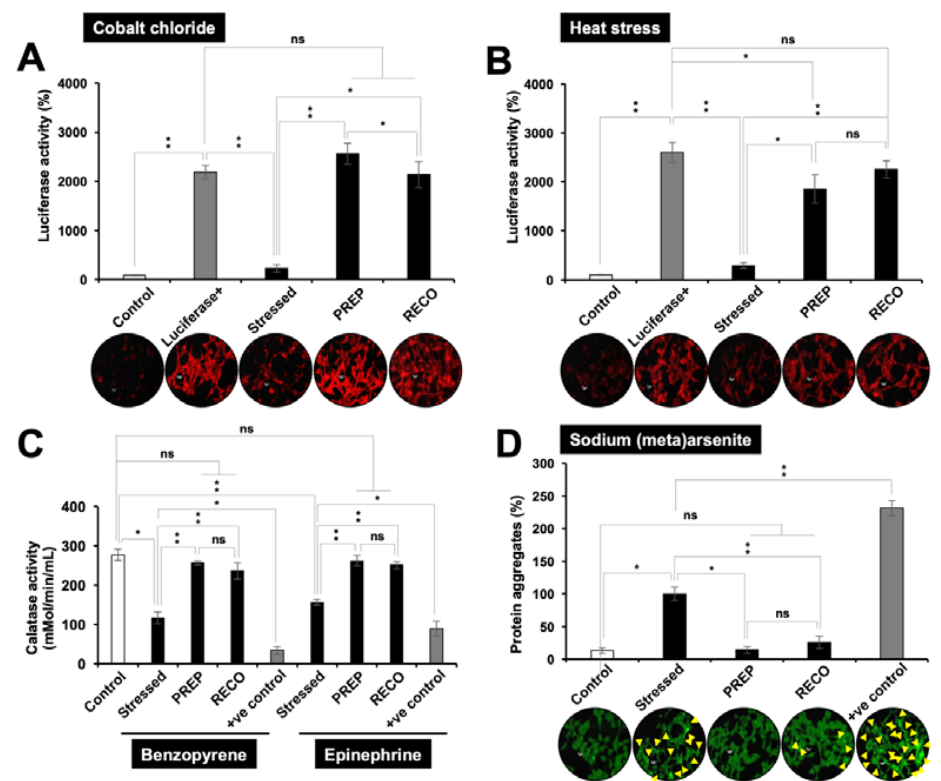
Figure 3. Luciferase reporter assay on control, cobalt chloride ( A ) and heat-stressed ( B ) treated cells in PREP and RECO modes. Relative units of luminescence (luciferase activity (%)) from three independent experiments were plotted. Cells exposed to metal (200 µ M cobalt chloride) and heat (42 ◦ C) stress showed inactivation of luciferase activity that was revived in resveratrol-treated cells. ( C ). Benzopyrene (30 µ M) and epinephrine (60 µ M) suppressed catalase (innate antioxidant enzyme) that was restored in resveratrol-treated cells. ( D ). Sodium (meta) arsenite (20 µ M) caused aggregation of GFP (shown by yellow arrowheads) that was de-aggregated in resveratrol-treated cells. A total of 250 µ M benzopyrene and 300 µ M epinephrine, and 150 µ M sodium (meta)arsenite were taken as positive controls in ( C ) and ( D ),